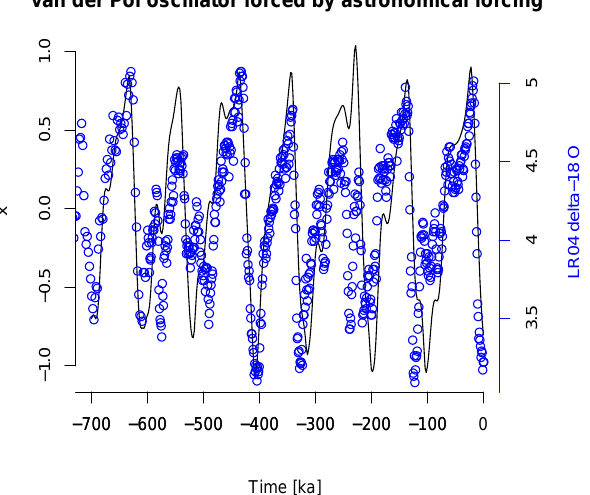
Fig. 3. Simulation with the van der Pol oscillator (Eqs. 1–4), forced by astronomical forcing and compared with the benthic record of Lisiecki and Raymo (2005). Parameters are: α = 30, β = 0 . 75, γ p = γ o = 0 . 6, τ = 36 . 2ka.